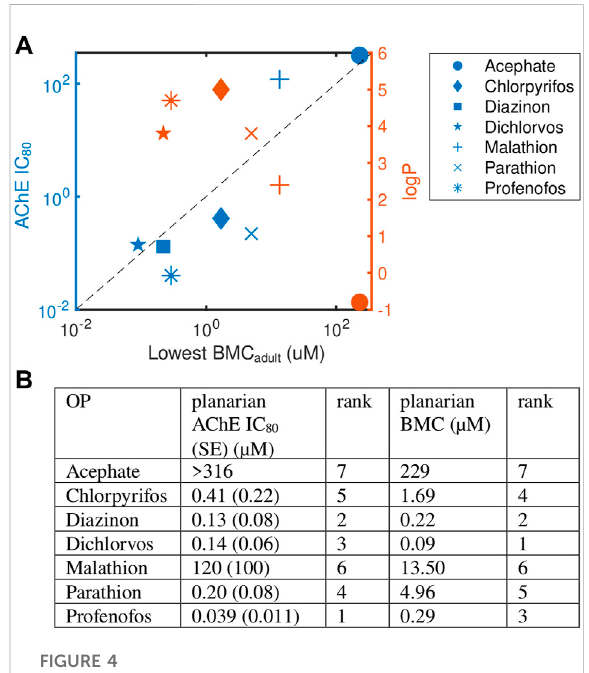
FIGURE 4 Levels of AChE inhibition is not correlated with phenotypic effects. (A) Comparison of OP potency (measured by the most sensitive BMC adult ) to AChE inhibition (IC 80 , blue) and hydrophobicity (logP, orange). Raw data and fi tted curves from the Ellman assays are shown in Supplementary Figure S6. For acephate, the IC 80 was set to the highest test concentration since no inhibition was observed. The dashed line is provided as a